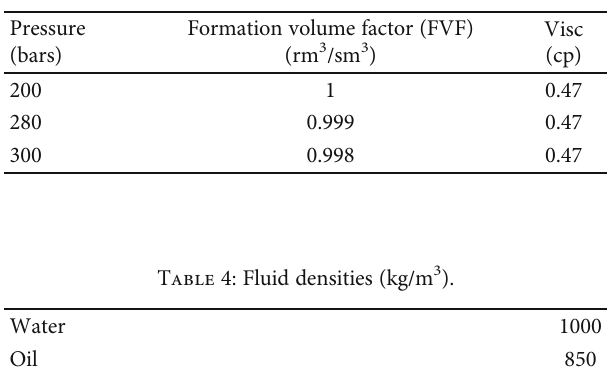
Table 3: Dead oil properties.